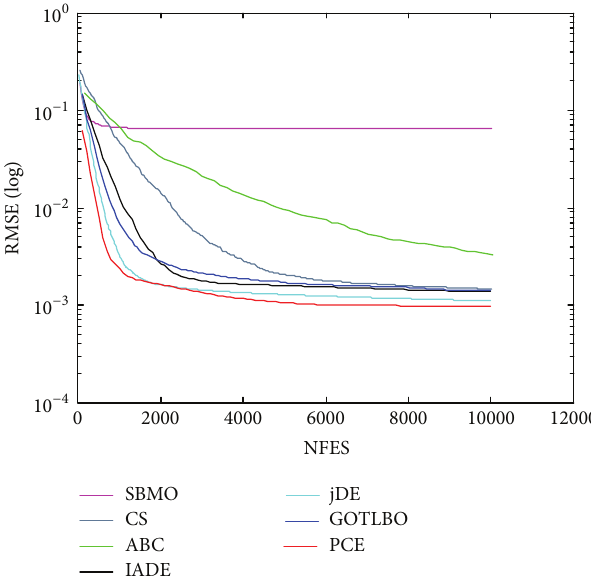
Figure 3: The convergence graph of different EAs for the single diode model.